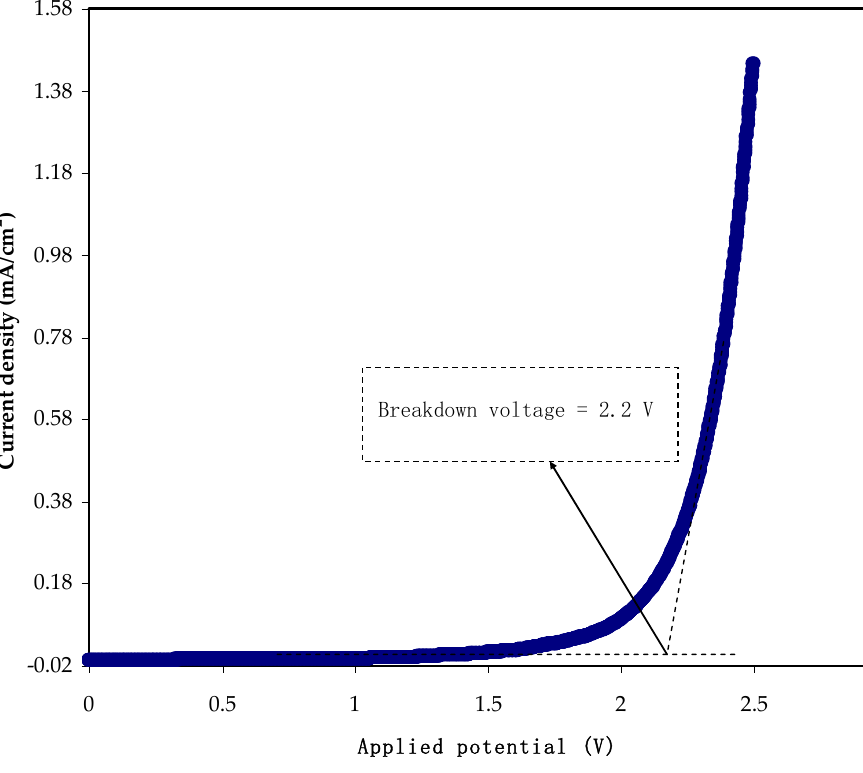
Figure 6. The LSV plot of the MC-KI-glycerol film with the highest conductivity.